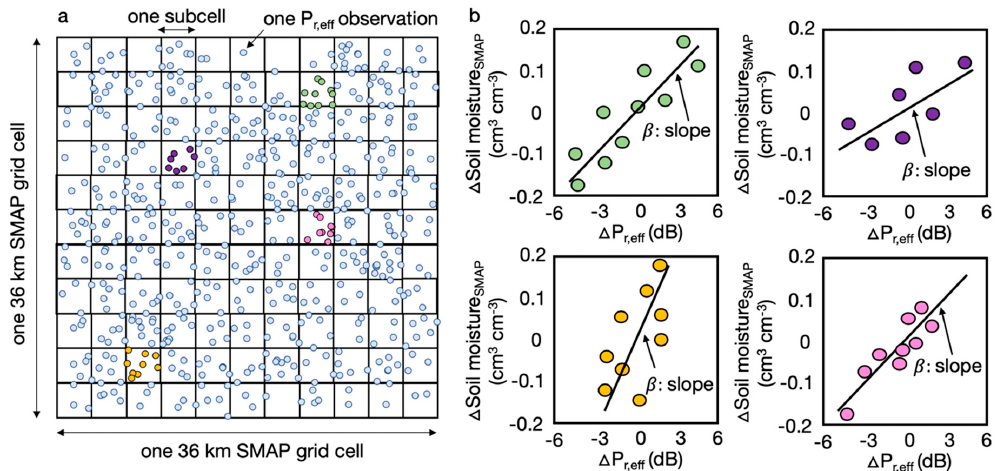
Figure 4. ( a ) Depiction of subcells within each 36-km EASE-2 grid cell, along with individual P r,eff observations (simplified as colored circles) used for calibration. ( b ) Depiction of how 𝛽 is calculated for subcells, with four different example subcells shown, which correspond to the different colored circles in ( a ). 𝛽 can be different for each subcell.